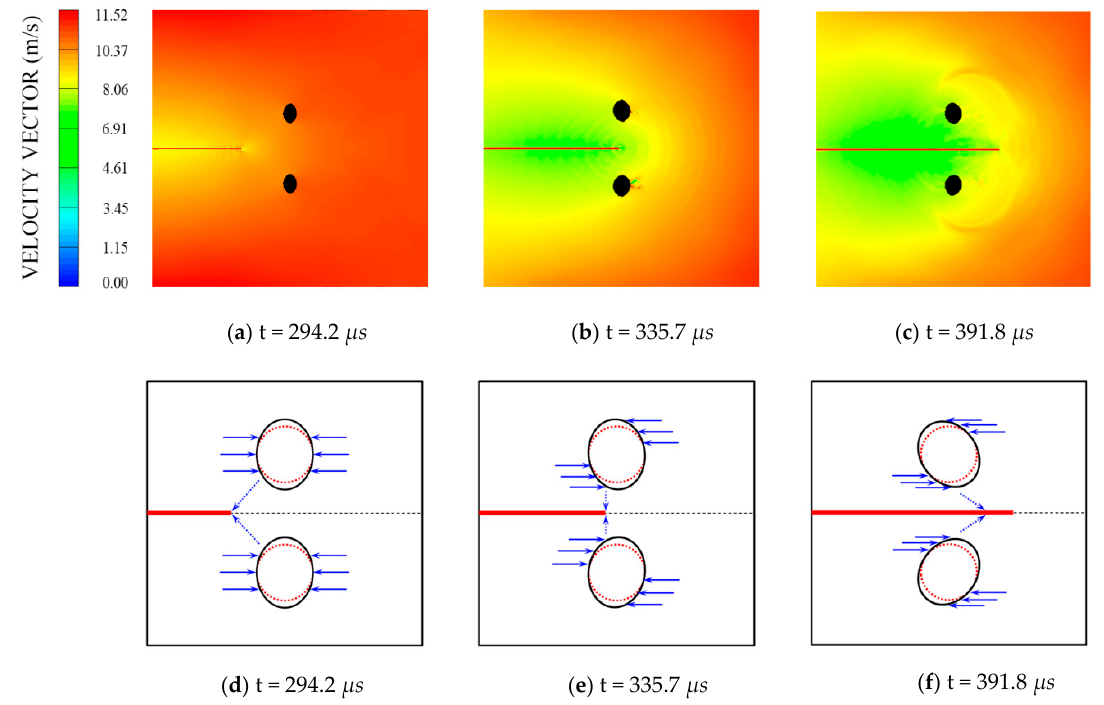
Figure 10. HT-1 specimen; ( a – c ) simulation results of the particle velocity vector contour plot calculated by AUTODYN; ( d – f ) principle diagram of the holes’